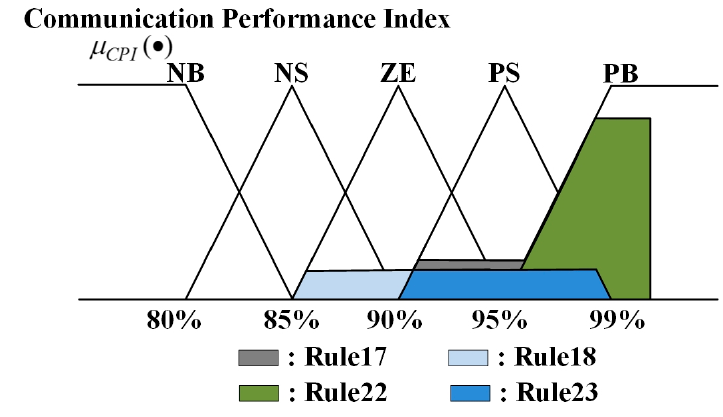
Figure 5. Results of Fuzzy Rules and Minimum Inference Engine.